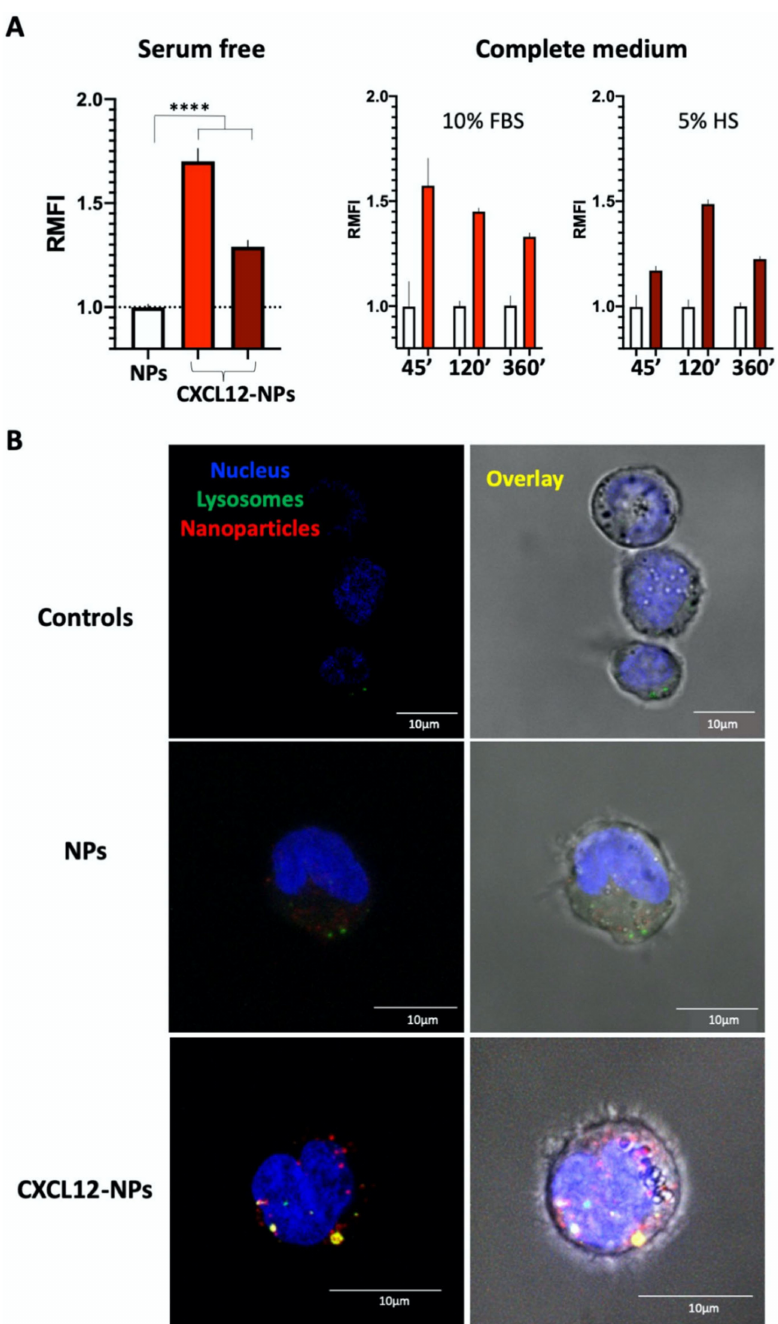
Figure 4. ( A ) CXCL12-NPs internalization in THP-1 cells cultured in 10% FBS / medium (red column) or 5% HS / medium (dark red column) after 45 min of NP administration in serum-free conditions (left graph) and after 45 min, 2 h and 6 h in both media conditions (10% FBS, center graph; 5% HS, right graph). Bars represent the relative median fluorescence intensity (RMFI) of at least three independent experiments +/ − SD. Statistically significant di ff erences were determined by unpaired t test with Welch’s correction **** p < 0.0001. ( B ) Confocal images of 10% FBS / medium-cultured THP-1 cells. Untreated cells (controls), cells treated for 45 min with non-functionalized NPs (NPs) and CXCL12-NPs. DAPI (blue) represents cell nucleus, Lyso-tracker (green) represents lysosomes and in red we show the Atto610 fluorescence of labeled NPs and CXCL12-NPs. The overlapping (yellow) of Atto610 (red) and LysoTracker (green) indicates nanoparticle co-localization with the lysosomes. Scale bar = 10 µ